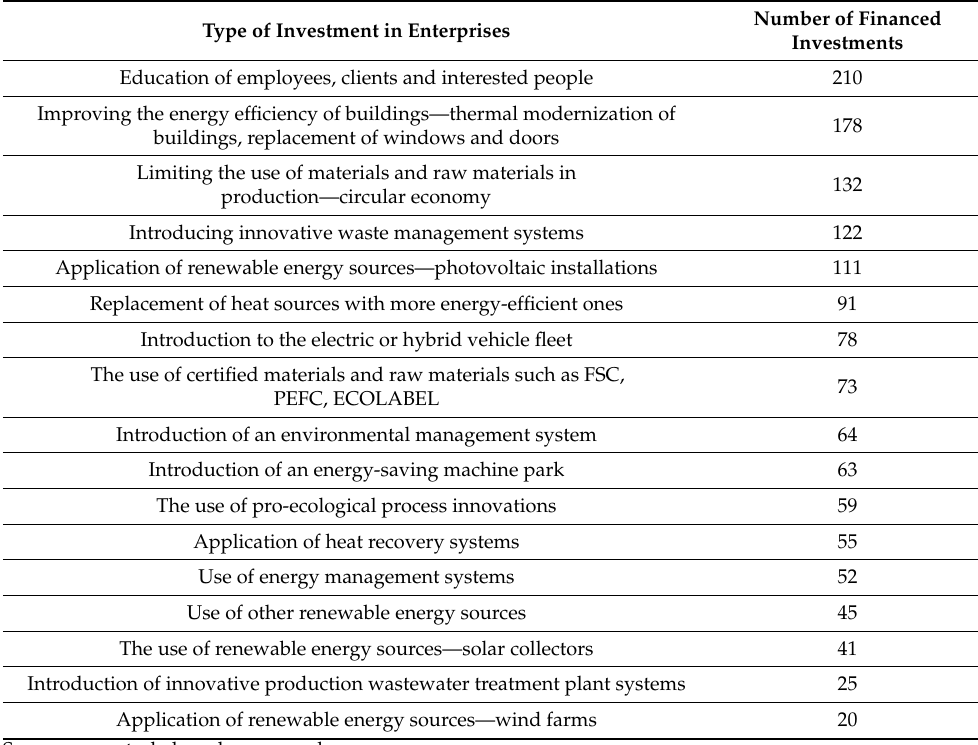
Table 1. Environmentally friendly investments financed in 2015–2020 by Polish